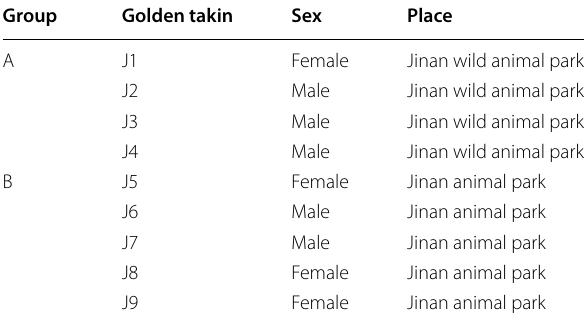
Table 1 Information on the characteristics of the golden takins used in this study Group